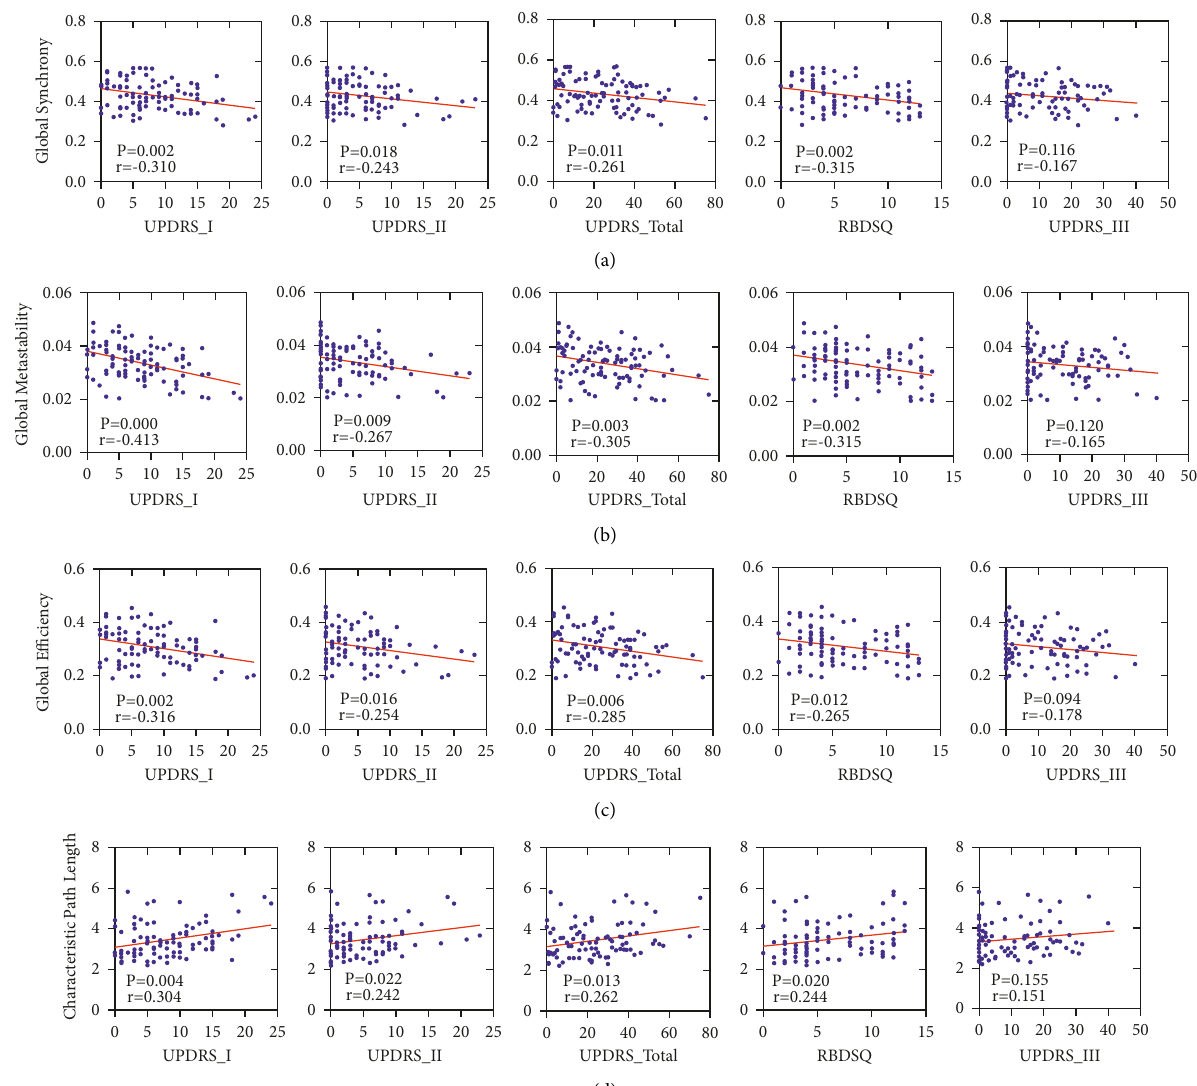
Figure 5: Correlations between neuroimaging measures and clinical features. (a) Correlation between global synchrony and UPDRS-I, II, III, total, RBDSQ. (b) Correlation between global metastability and UPDRS-I, II, III, total, RBDSQ. (c) Correlation between global efficiency and UPDRS-I, II, III, total, RBDSQ. (d) Correlation between characteristic path length and UPDRS-I, II, III, total,